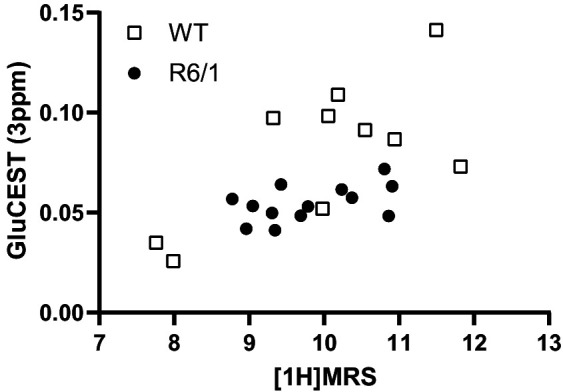
Correlation of glutamate levels obtained from GluCEST and 1H MRS in the striatum.Data are represented as mean ± SEM (WT n = 10 and HD n = 13 mice). Each point represents data from an individual mouse. Pearson correlation shows r = 0.5979 with p = 0.0026.